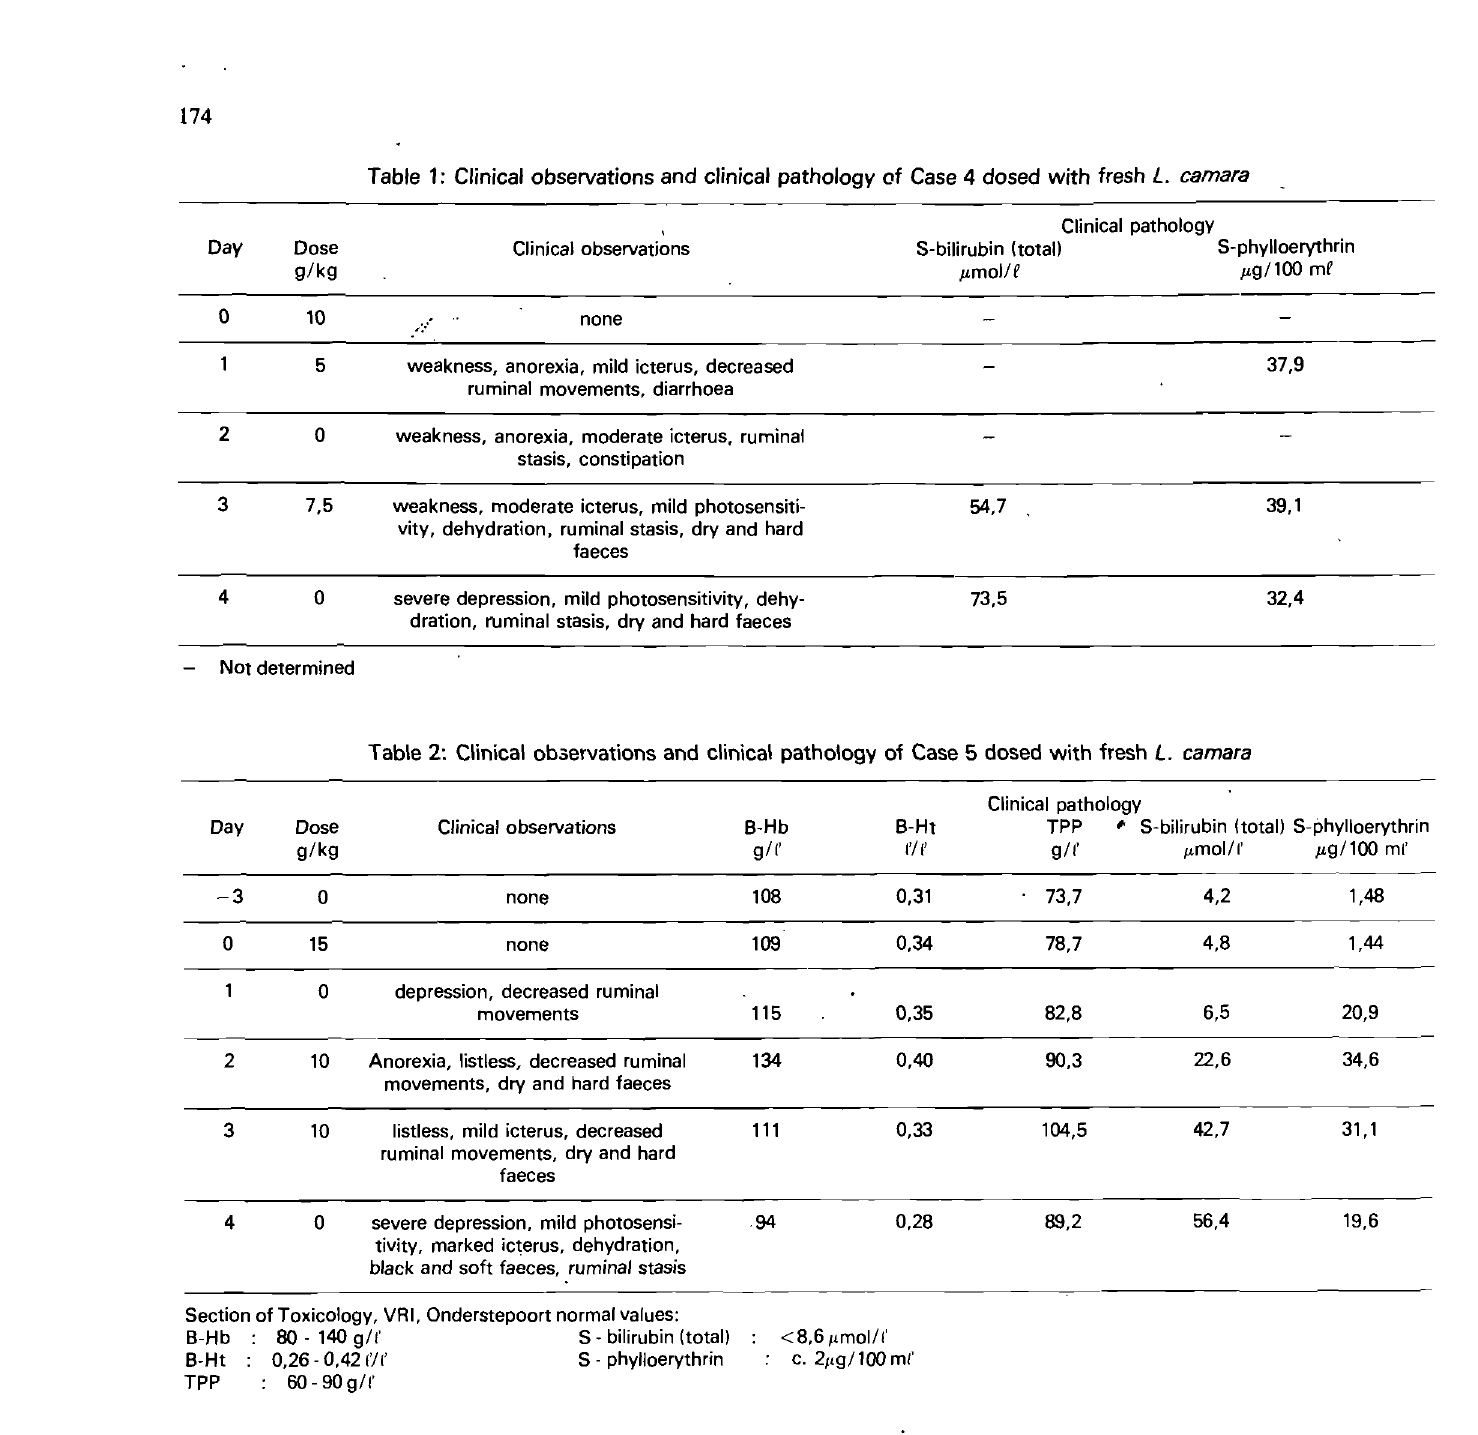
Table 1: Clinical observations and clinical pathology of Case 4 dosed with fresh L.